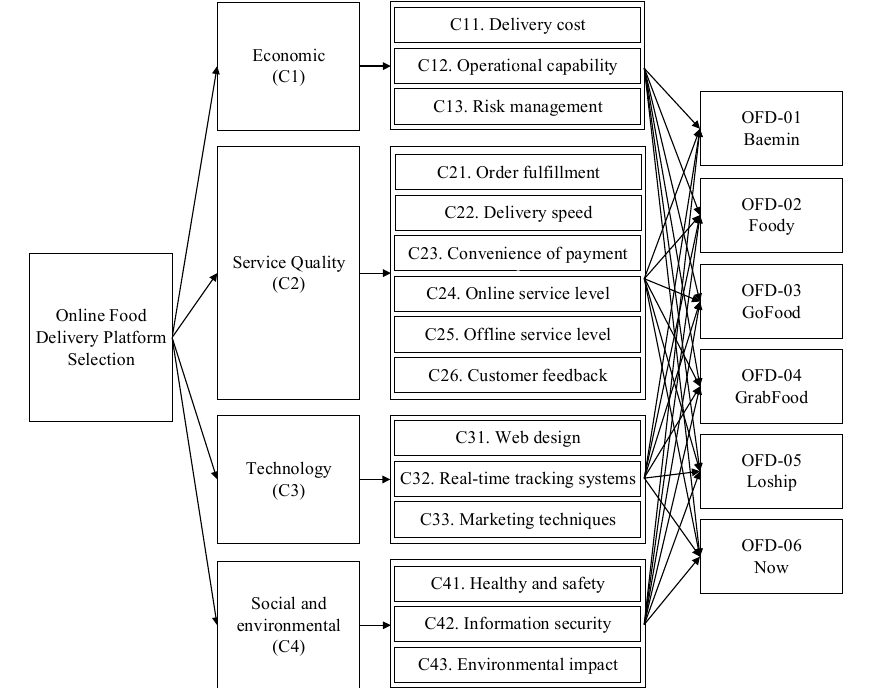
Figure 3. The decision hierarchy for evaluation and selection OFDs.